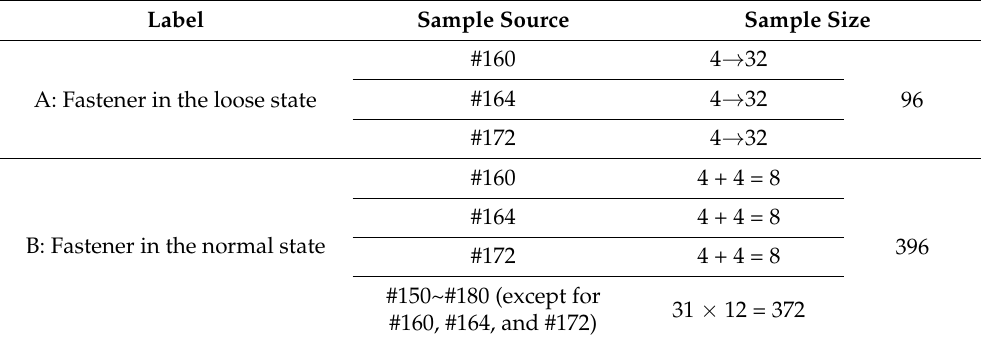
Table 2. The composition and size of the experimental dataset.